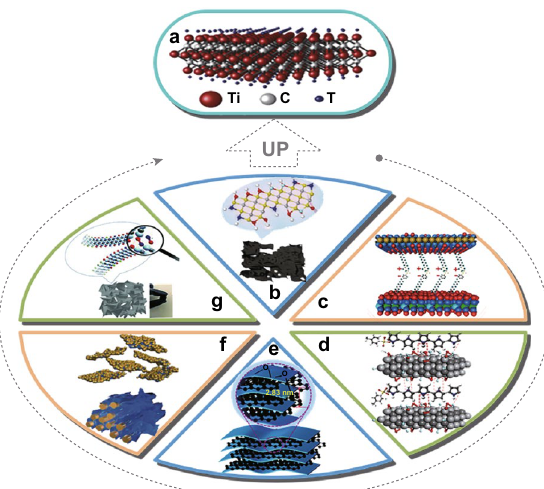
Fig. 1 Enhancing the capacitance of Ti 3 C 2 T x as electrode materials of supercapacitors. a Structure of Ti 3 C 2 T x [21]. b N-doped Ti 3 C 2 T x [36]. c Ti 3 C 2 T x /layered metallic double hydroxides [37]. d Ti 3 C 2 T x / conductive polymers [41]. e Carbon-intercalated Ti 3 C 2 T x